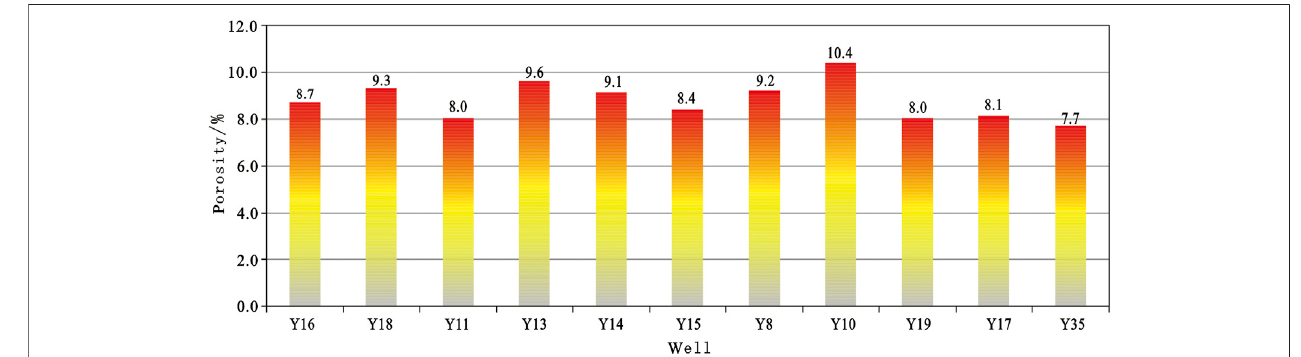
FIGURE 8 | Porosity distribution histogram of the Leping Formation carbonaceous shale in the study area.